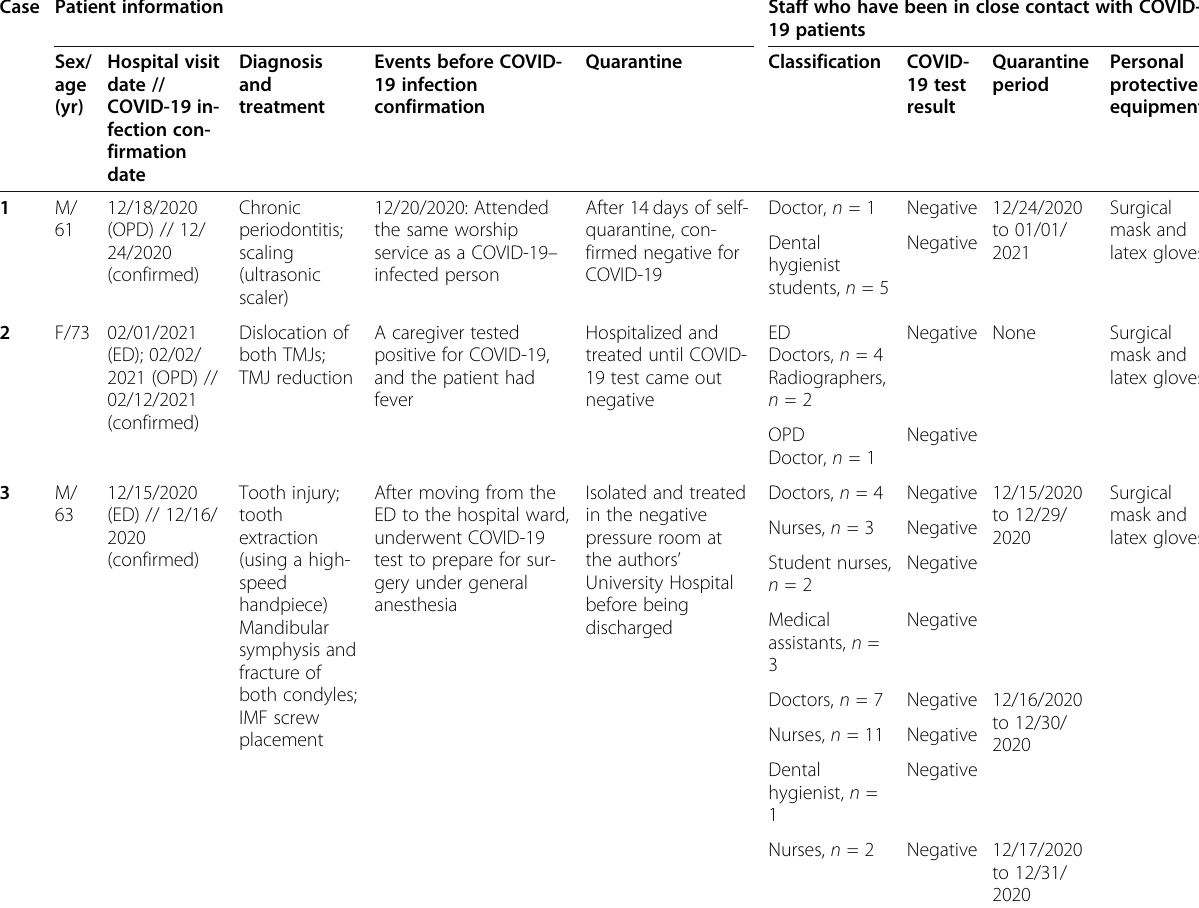
Table 2 Summary of dental treatments performed on asymptomatic COVID-19 patients ( n = 3) Case Patient